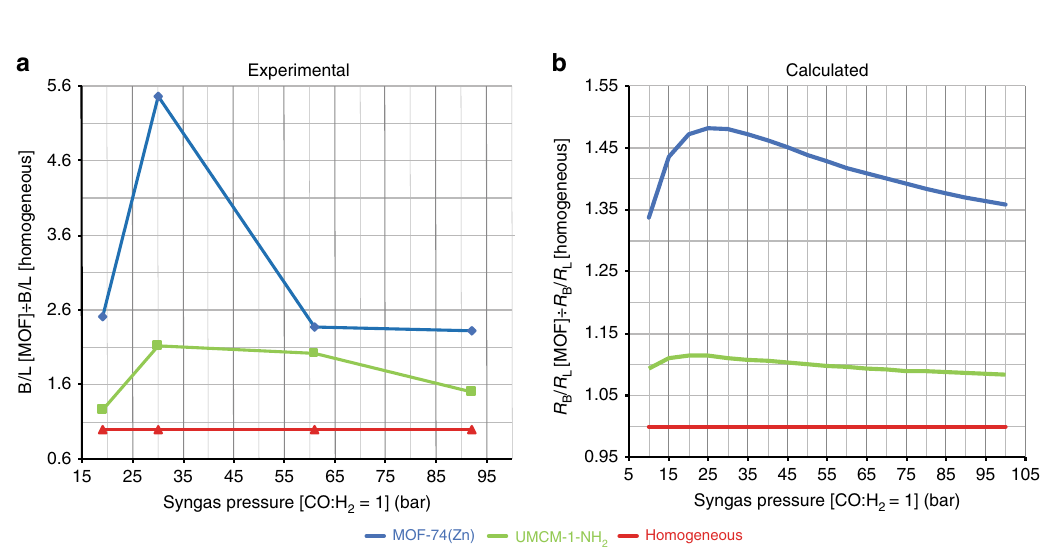
Fig. 3 Experimental and calculated selectivity comparison. a Experimental branched to linear ratios (B/L) with MixUMCM-1-NH 2 (28%) and MOF-74 (Zn) relative to the homogeneous B/L as function of syngas pressure (Supplementary Table 9). b Calculated relative rates of formation of the branched and linear aldehydes ( R B / R L ) in the MOFs UMCM-1-NH 2 and MOF-74(Zn) and homogeneous phase referenced to the homogeneous system as a function of syngas pressure.